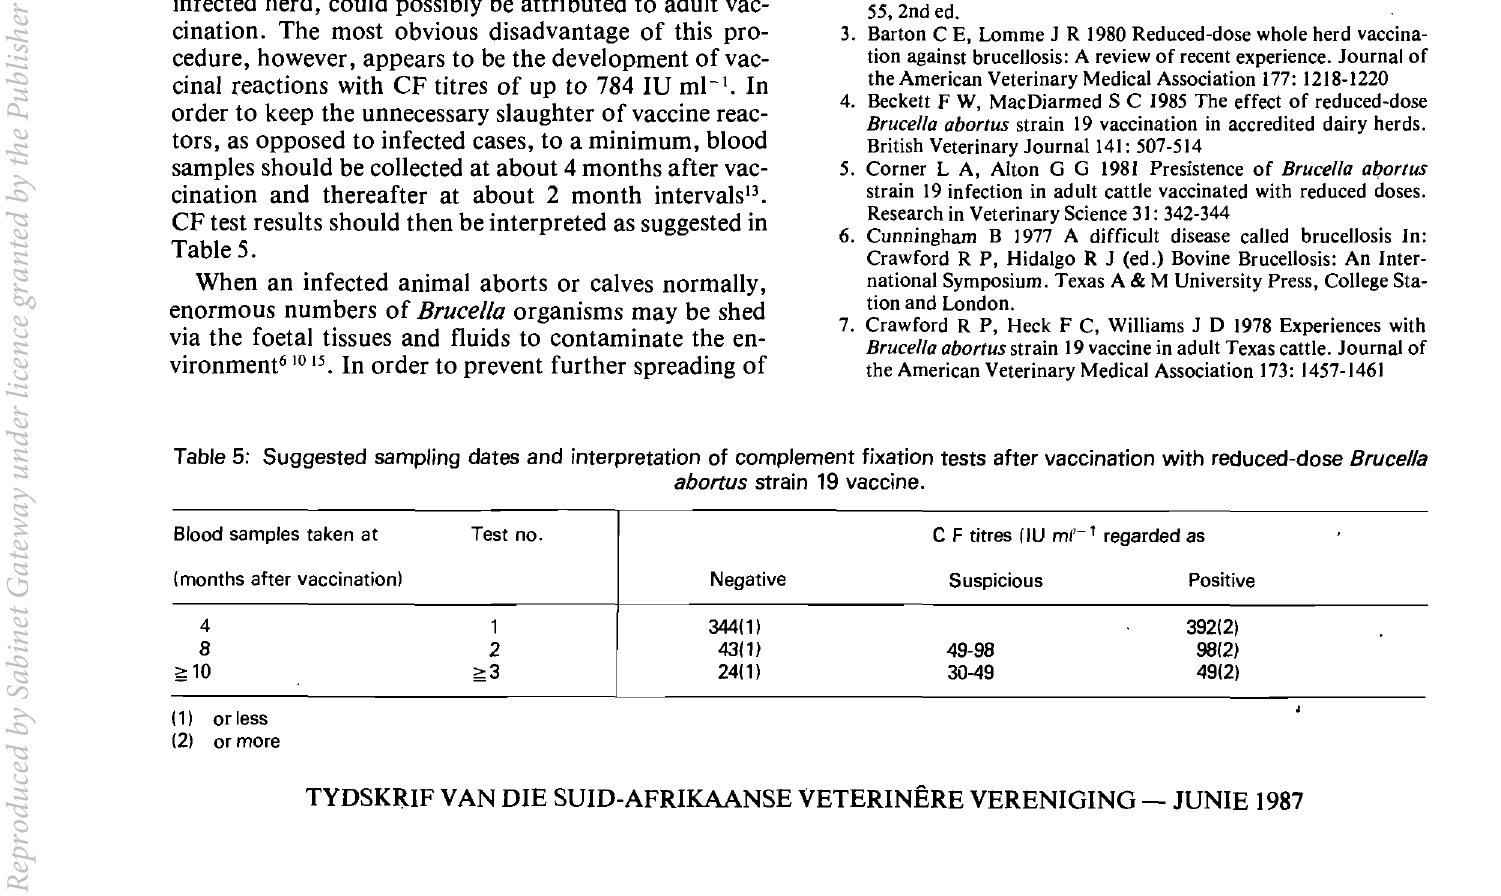
abortus strain 19 vaccine.